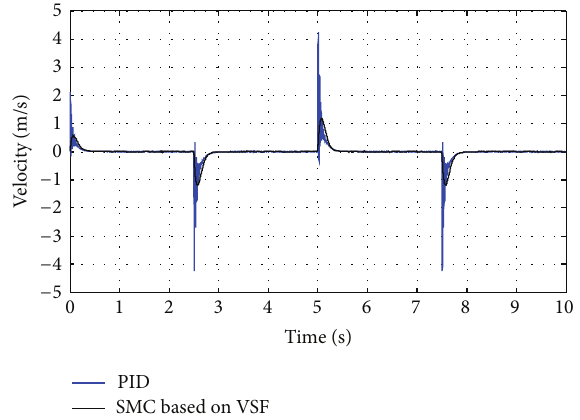
Figure 11: Comparison of the tracking velocities when using different controllers.